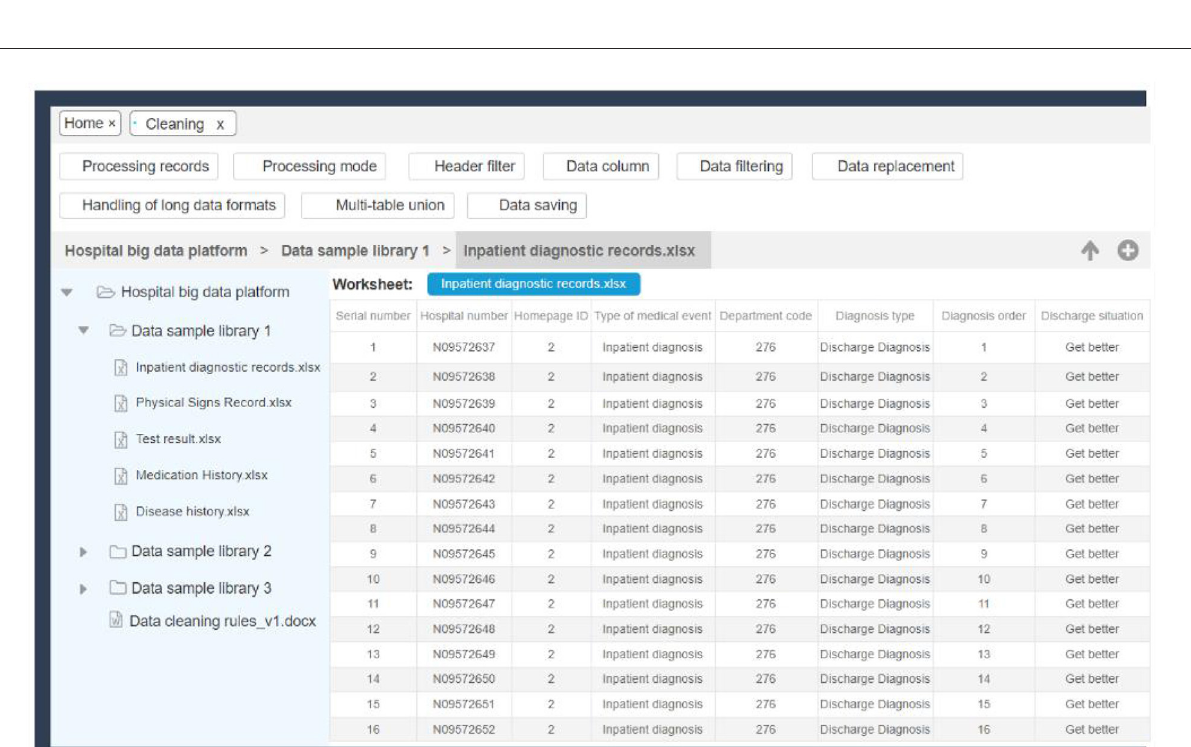
FIGURE5 Medical knowledge base interface.